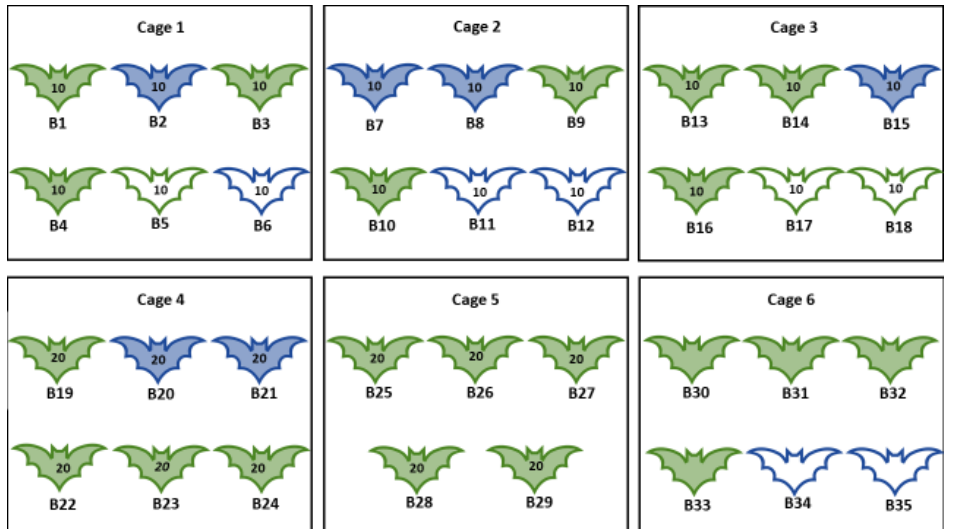
Figure 6. Experiment I. Number, sex, MARV ‐ inoculation status of bats, and the number of bat flies released on Egyptian rousette bats. B = Bat identification number 1–35; Green outline = Female; Blue outline = Male; number on the bat = Number of flies released on each bat; Coloured in bats = Bats inoculated with Marburg virus; Not coloured in bats = Bats mock inoculated.